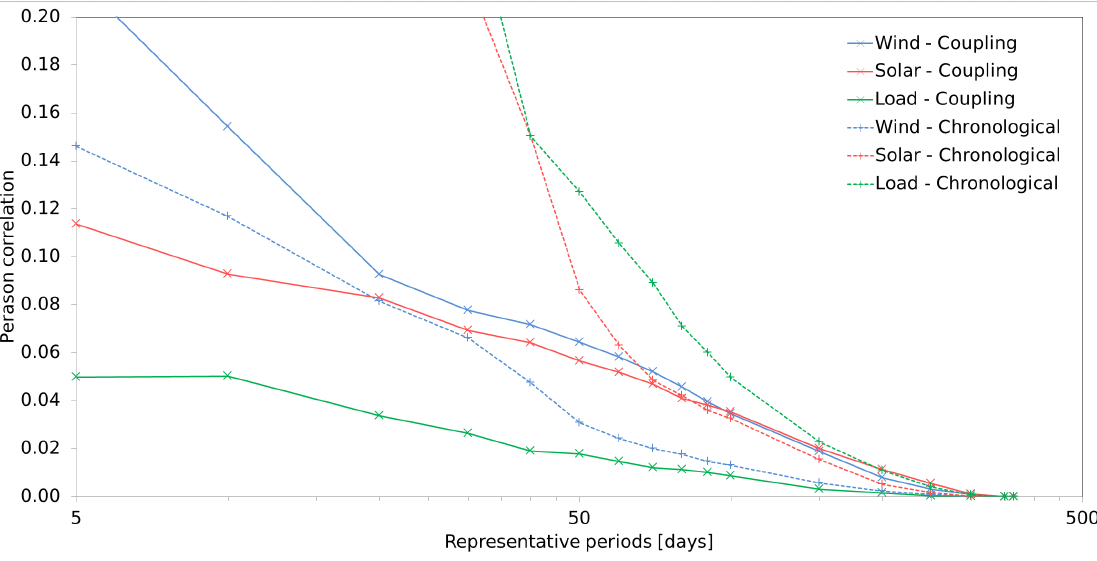
Figure 5. Pearson correlation for the coupling and chronological clustering for the load, wind and solar energy, using different representative